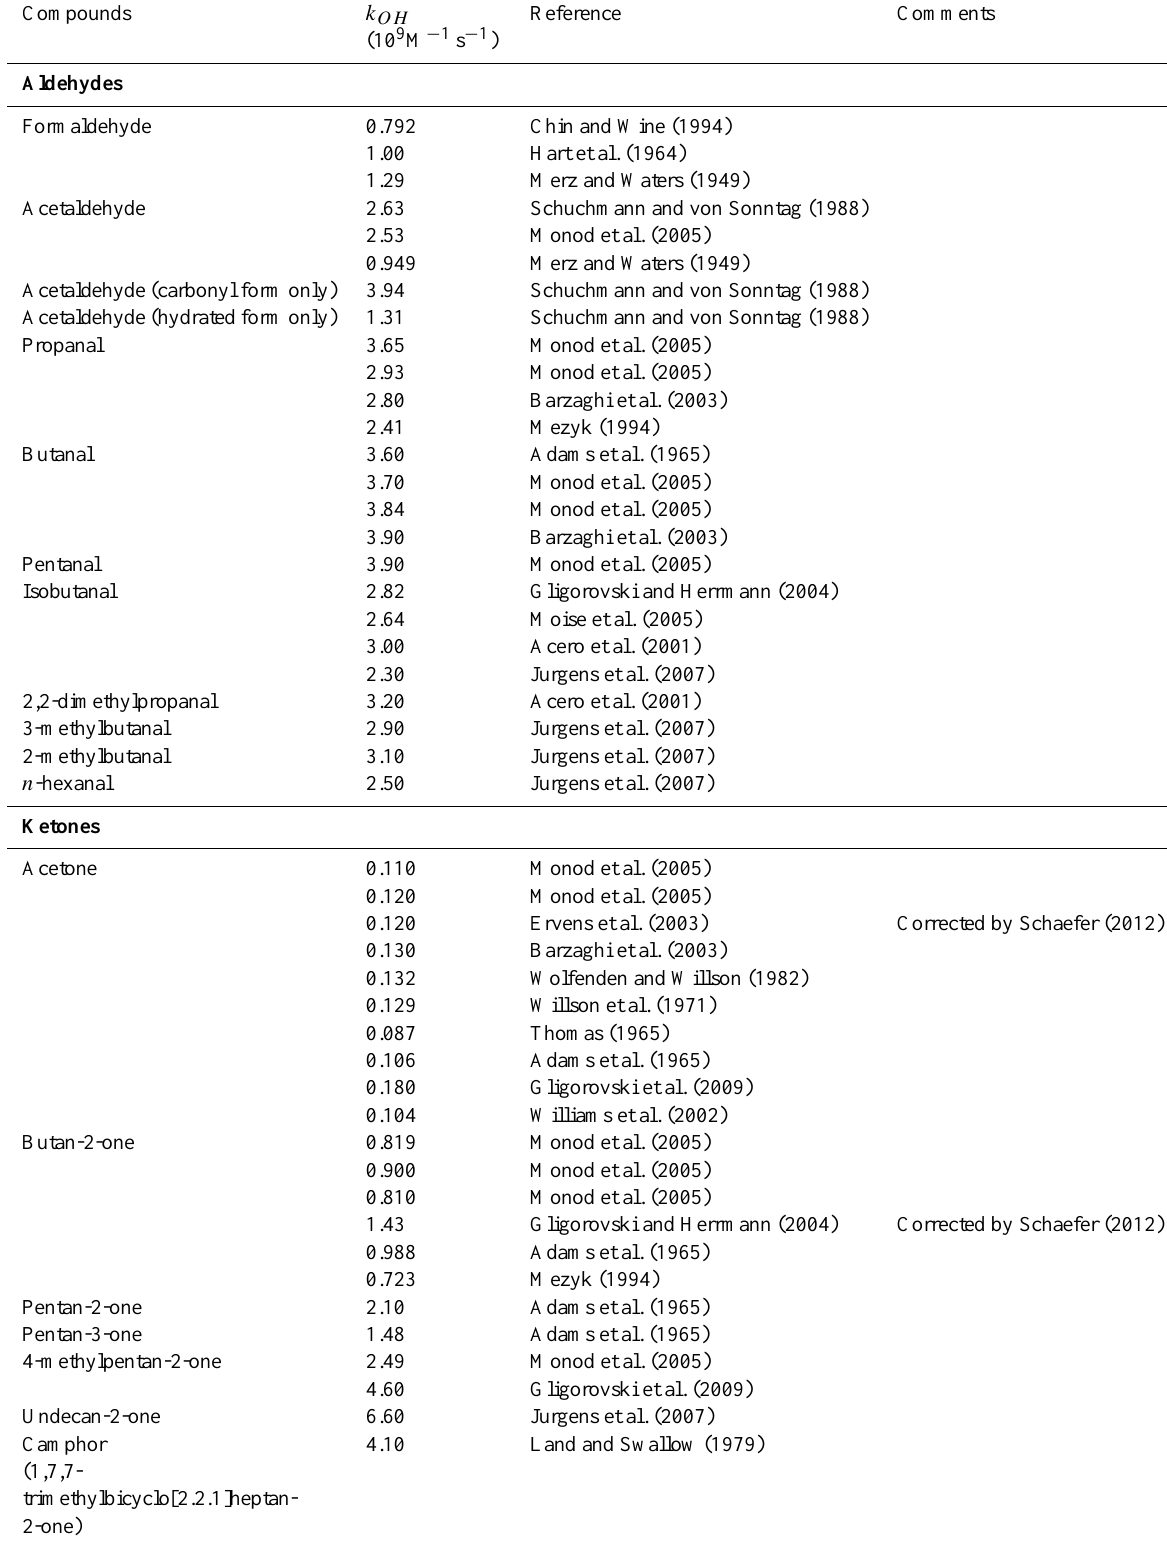
Table 4. Database for the rate constants of OH-oxidation of aldehydes, ketones and polyfunctional carbonyl compounds.